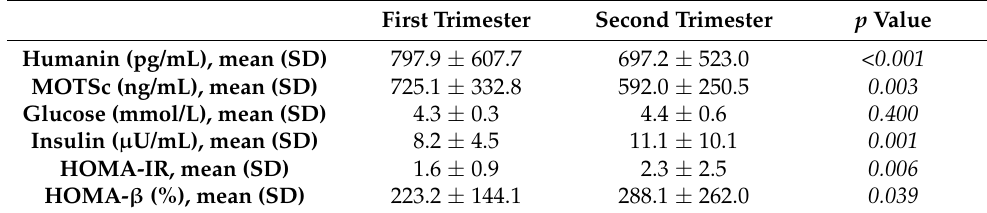
Table 2. Evolution of mitochondria-derived peptides HOMA-IR and HOMA- β between the first and second trimesters of gestation in the total cohort.